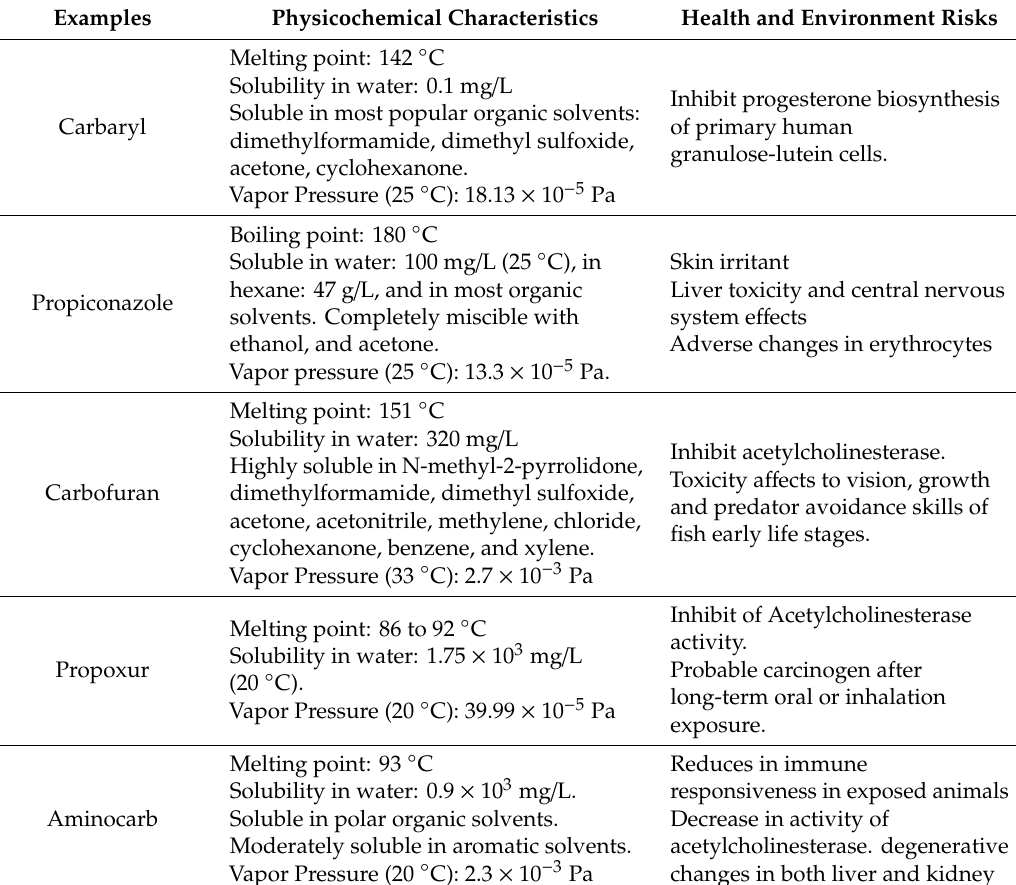
Some examples of carbamates pesticides, which are derived from carbamic acid (NH 2 COOH) [10,13,16–18].